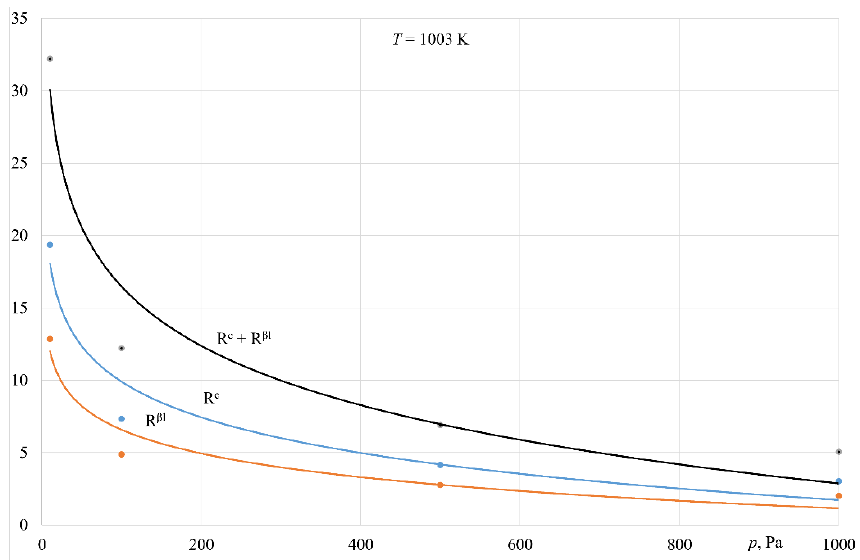
Figure 11. Variation in the resistance of mass transfer in the liquid phase( R βl ) and reaction on the surface of the liquid metal ( R e ) in overall resistance of evaporation process vs. pressure (induction furnace with a cold crucible).